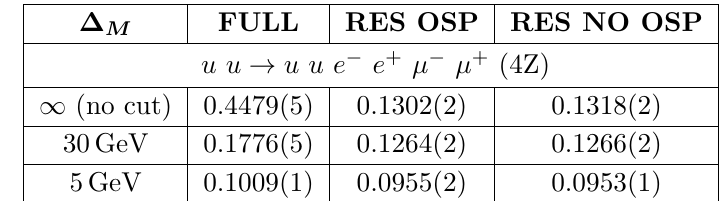
Table 3 . Cross sections ( ab ) for u u All diagrams are taken into account for the full calculation (FULL), while only double resonant diagrams contribute to the two rightmost columns, with (RES OSP) and without (RES NO OSP) projection. Selection cuts are: p j 300 GeV, M > 40 GeV. ‘ + ‘ (cid:0)